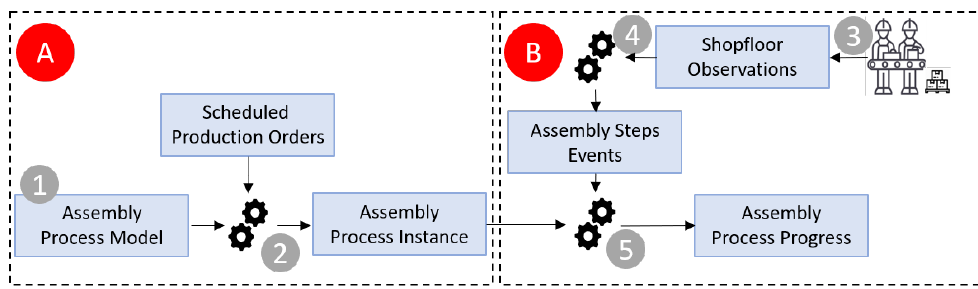
Figure 5. Proposed monitoring approach for cognitive shop floor. This depicts a step by step approach followed for representation of the assembly process, where ( A ) represents modeling and ( B ) represents